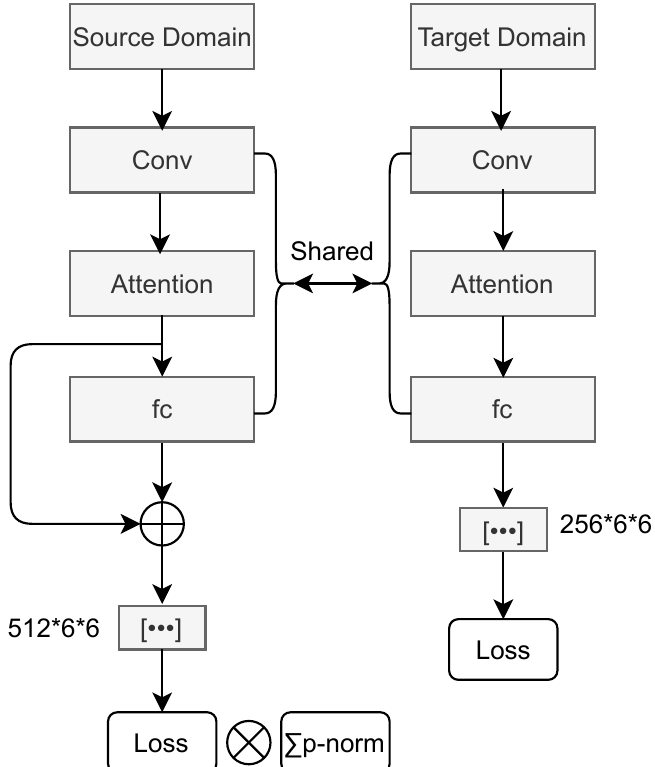
Figure 2. The architecture of P-ADC. ⊕ denotes the stack operation. For example, if the size of a and b is 256 × 6 × 6, respectively, then the size of a ⊕ b should be 512 × 6 × 6. ⊗ is the addition operation, i.e., classification loss + p-norm